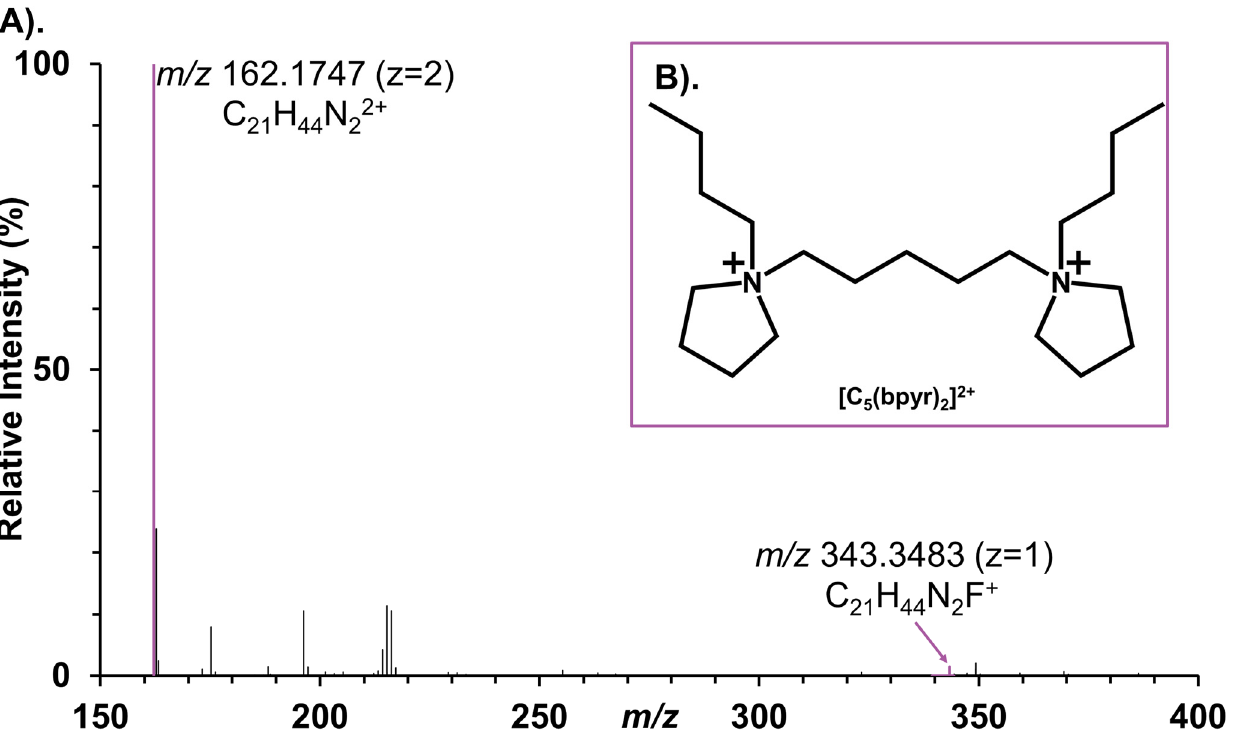
Figure 1. ( A ). Mass spectrum of [C 5 (bpyr) 2 ] 2+ at 10 µ M doped in the 50% MeOH/H 2 O ( v / v ) electrospray solvent. Peaks related to [C 5 (bpyr) 2 ] 2+ are labeled in purple. ( B ). Dicationic chemical structure of [C 5 (bpyr) 2 ] 2+